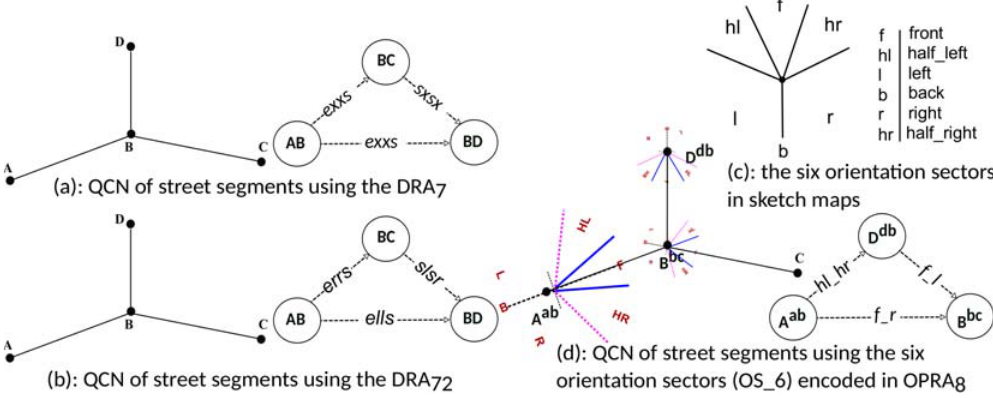
Figure 3: (a) QCN of street segments using the DRA 7 , (b) QCN of street segments using the DRA 72 , (c) the orientation sectors found in sketch maps, (d) the orientation of connected street segments using the six orientation sectors encoded in OPRA 8 .